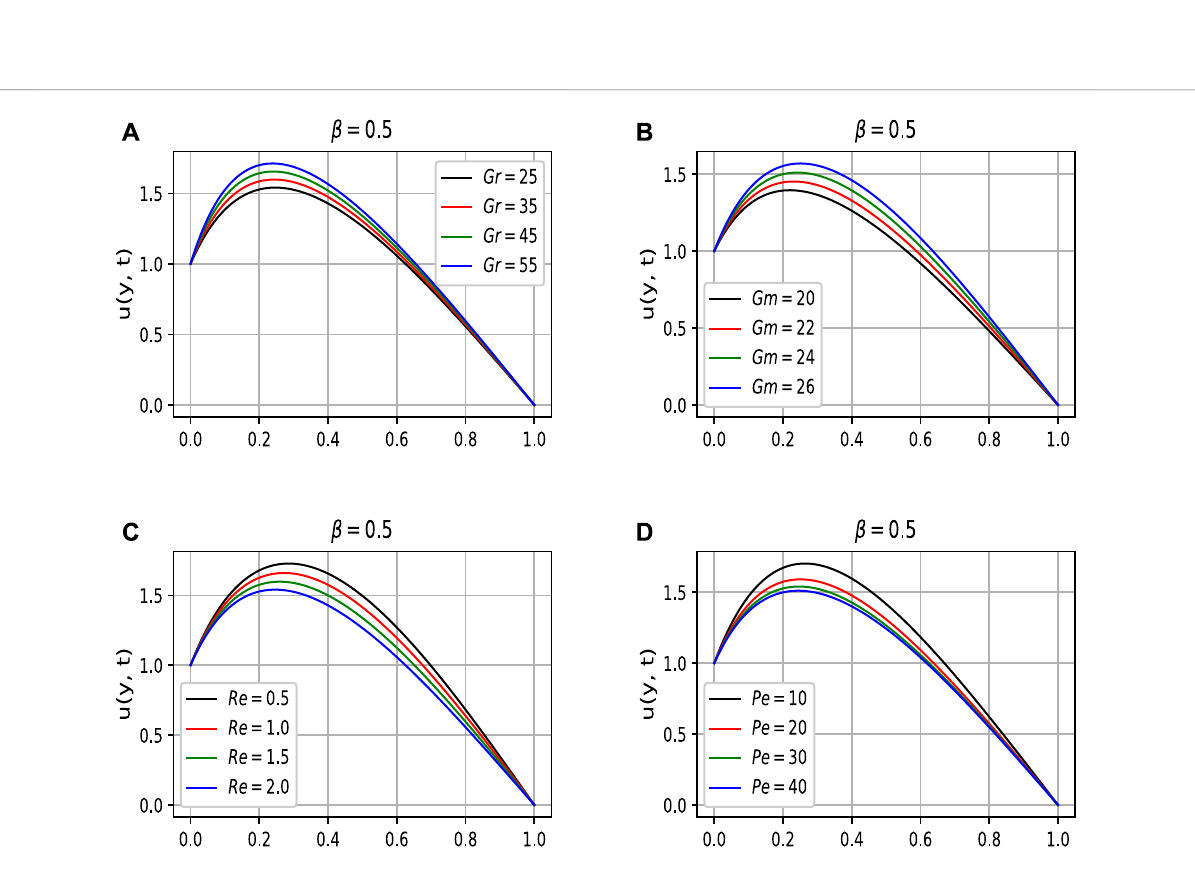
FIGURE 3 The behaviour of the boundary layer velocity as the parameters Gr , Gm , Re and Pe vary.